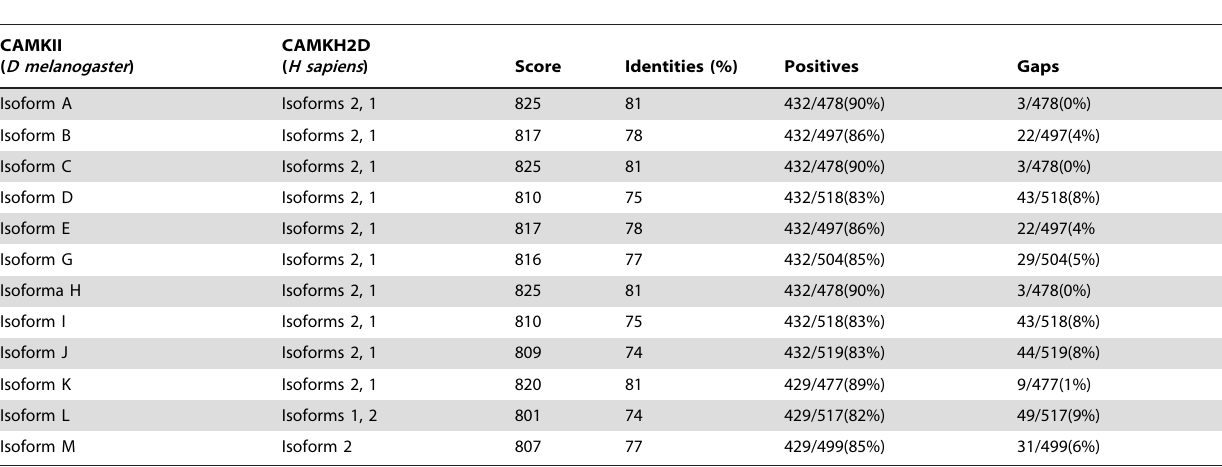
Table 1. CaMKII from Drosophila melanogaster exhibit high homology with the product of human gene CaMK2D.